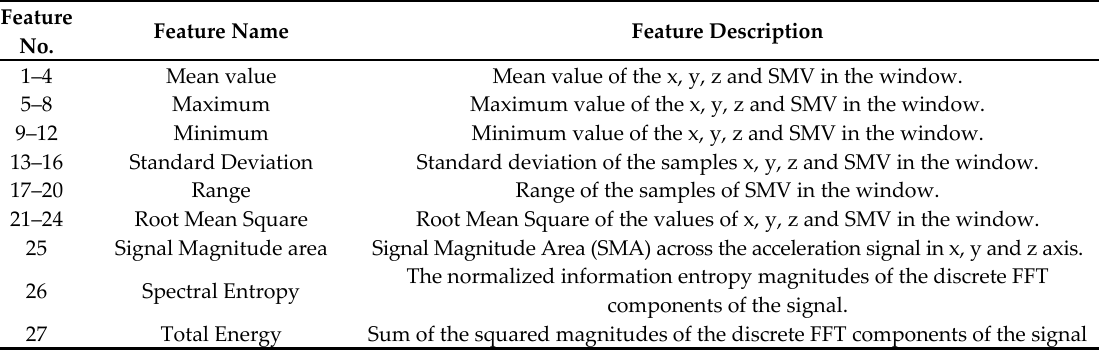
Table 2. Initial considered